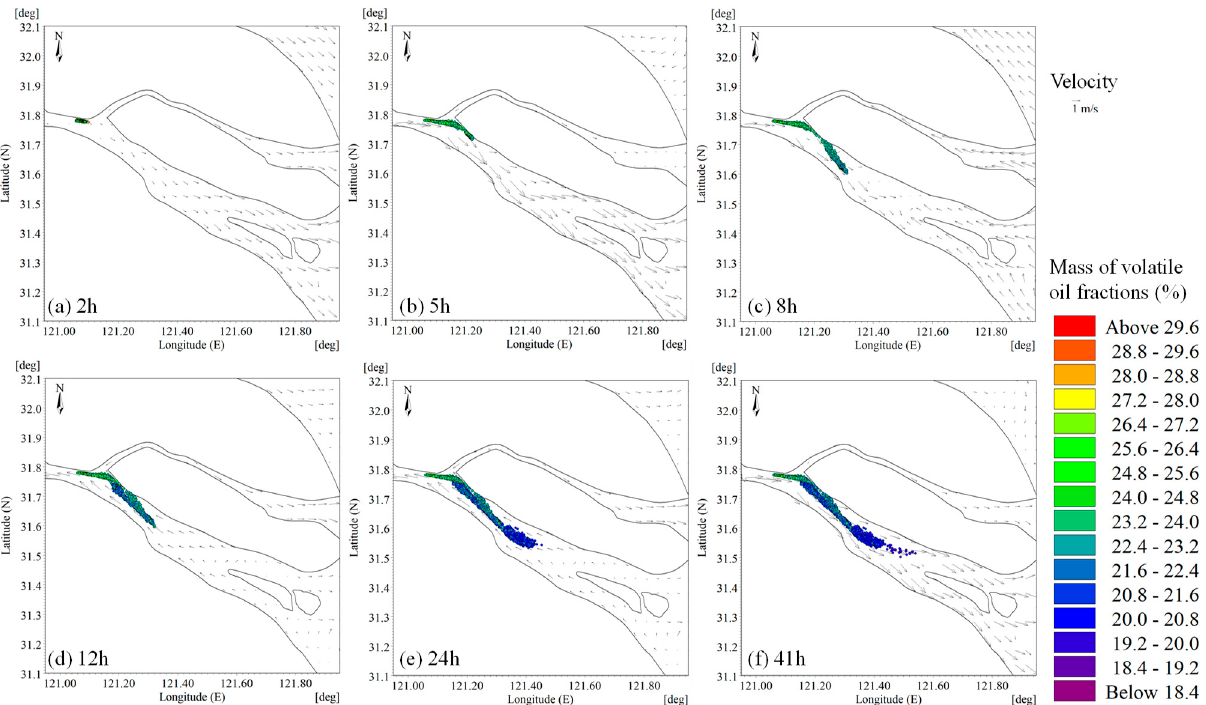
Figure 9. ( a – f ) Time evolution of oil particle track within 41 h starting at 2:00 on 25 September 2014 after Typhoon Fongwong affected the YRE. The color of circles indicates the mass of volatile oil fractions whose weight is below 160 g/mol, boiling point well below 300 deg C.